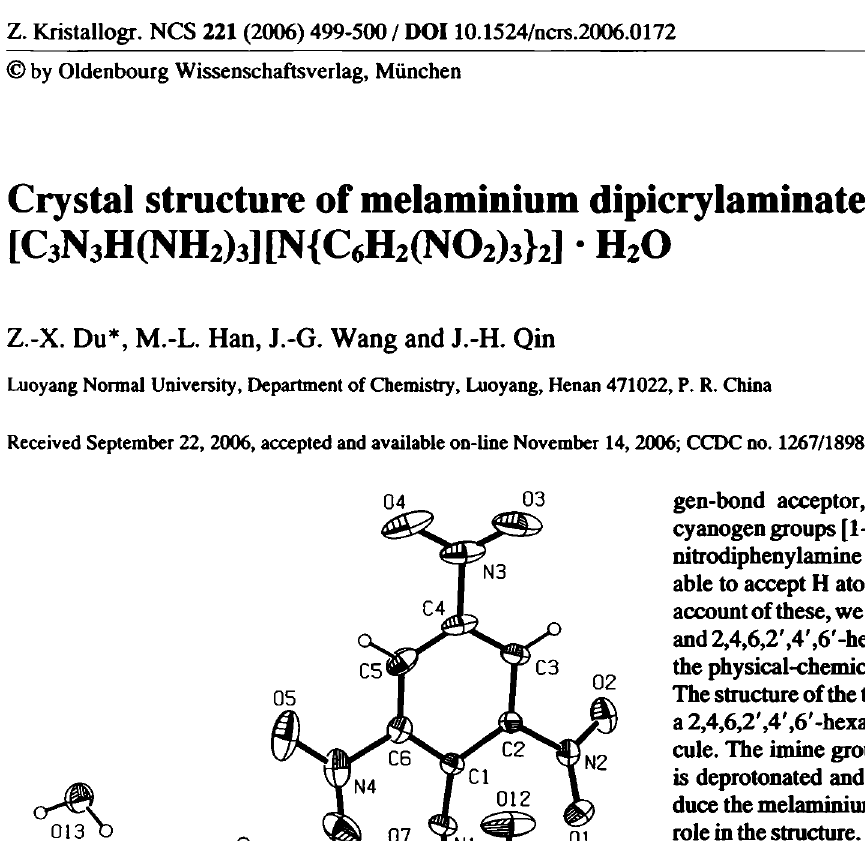
Table 1. Data collection and handling.